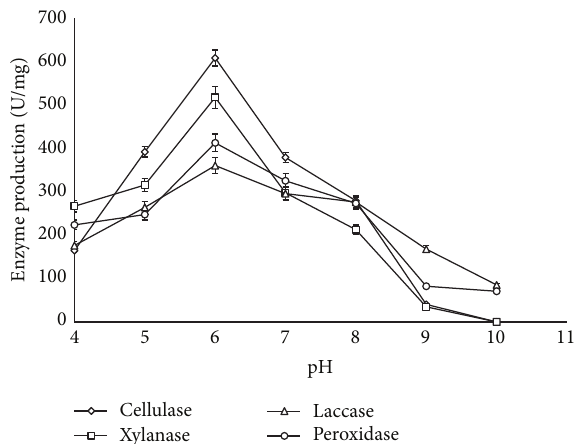
Figure 6: Effect of pH on production of lignocellulolytic enzymes (error bars represent mean values and standard deviation of tripli- cate